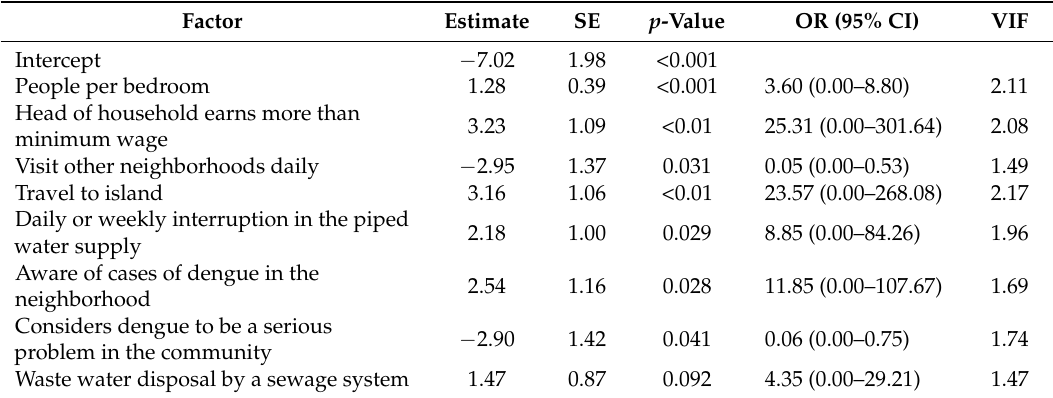
Table 3. Summary of the best-fit model * for self-reported prior dengue